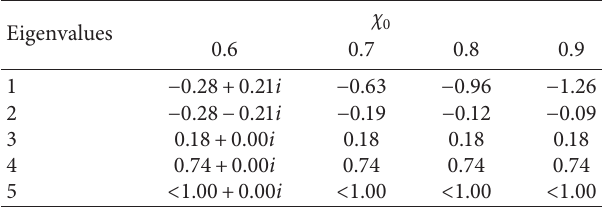
( C n ,C n , P n ) under different χ r,p r,e r,fp Ψ